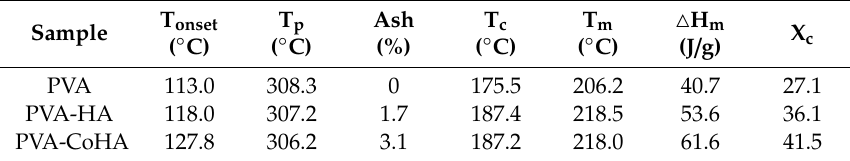
Figure 4. ( A ) TGA patterns, ( B ) DSC patterns, ( C ) swelling behaviors curve, and ( D ) free radical scavenging ability of PVA and PVA-CoHA nanocomposites. Means with different letters ( a – c ) were significantly different ( p < 0.05, mean ± SD, n = 4). Table 2. Thermal properties of PVA and PVA/CoHA nanocomposites.